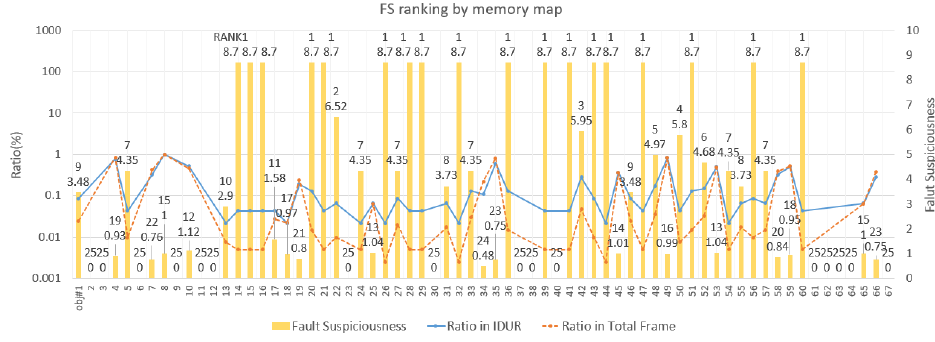
Figure 13. FS ranking by memory map.